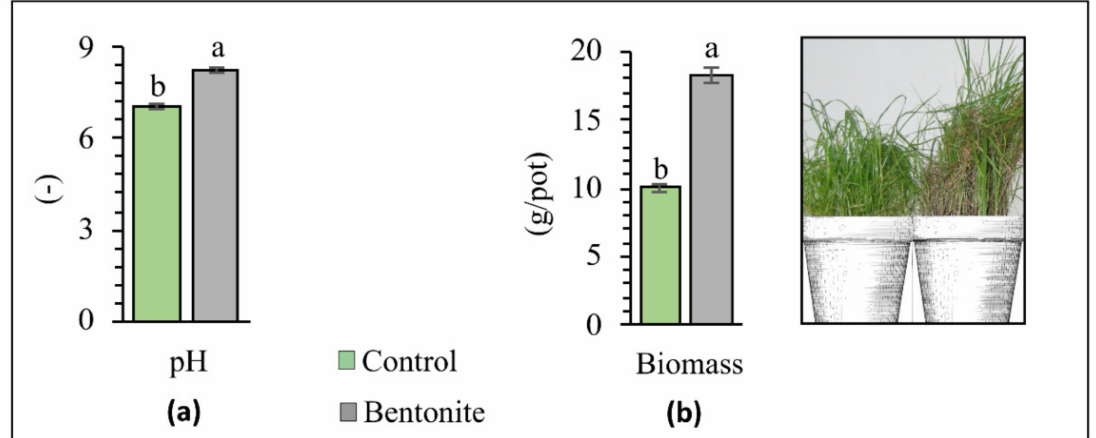
Figure 1. Soil pH ( a ) and plant biomass ( b ) after phytostabilization. Different letters indicate significant differences ( p < 0.05) between the control samples and those to which bentonite was added.